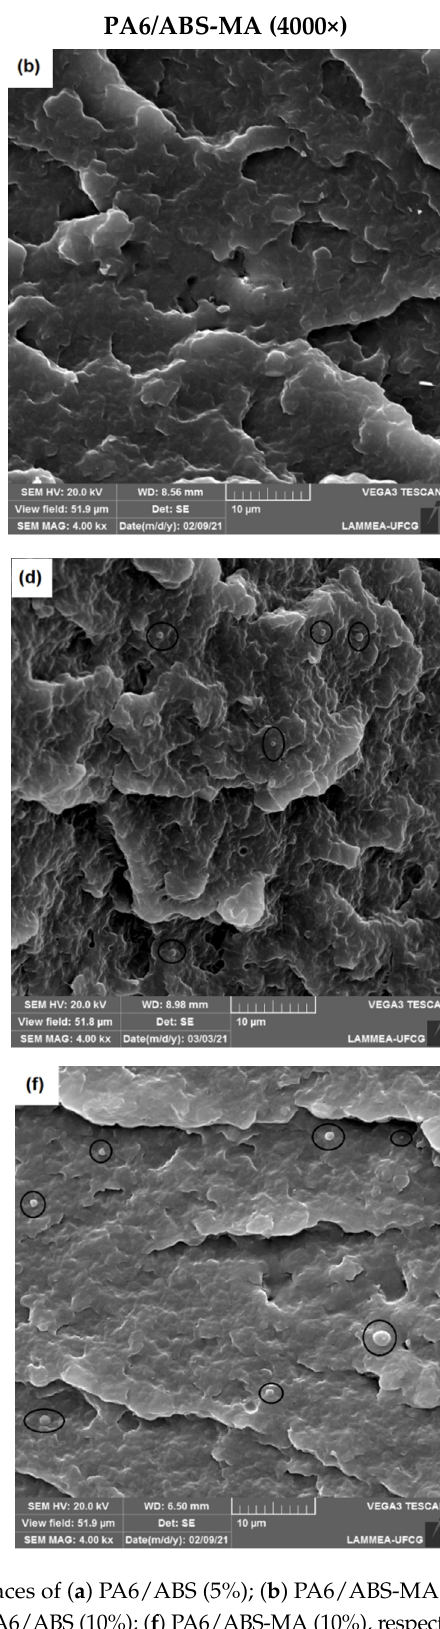
Figure 6. SEM micrographs showing the morphology on the fracture surface of pure PA6: ( a ) 500× magnification; ( b ) 2000× magnification.